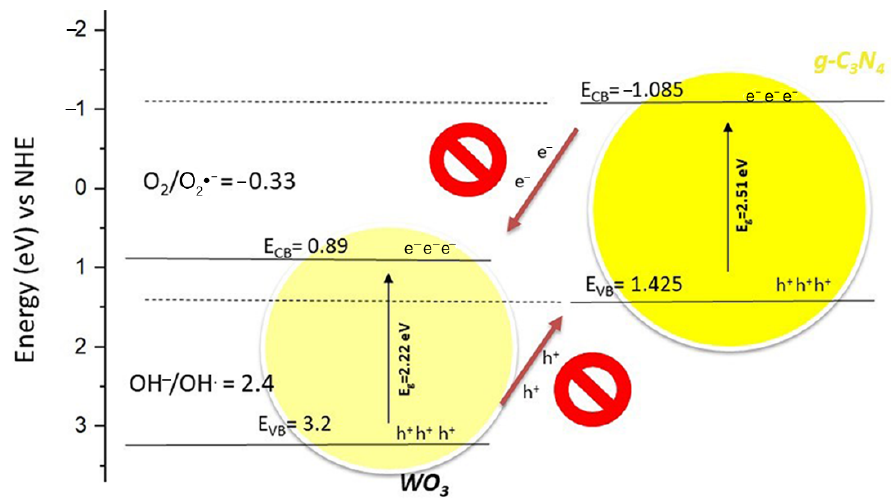
Figure 8. Illustration of improbable type-II photocatalytic mechanism for the composite materials.